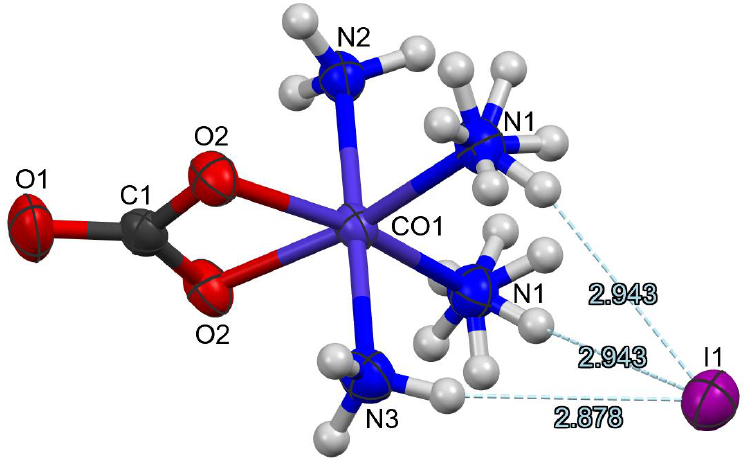
Figure 1. Structure of compound 1 at 100 K (thermal ellipsoids are drawn at the 50% probability level, hydrogen bonds between the ammonia ligands and the iodide anion are drawn by blue dashed lines).